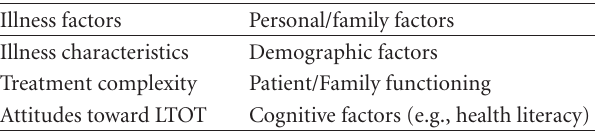
Table 2: Factors influential to patient